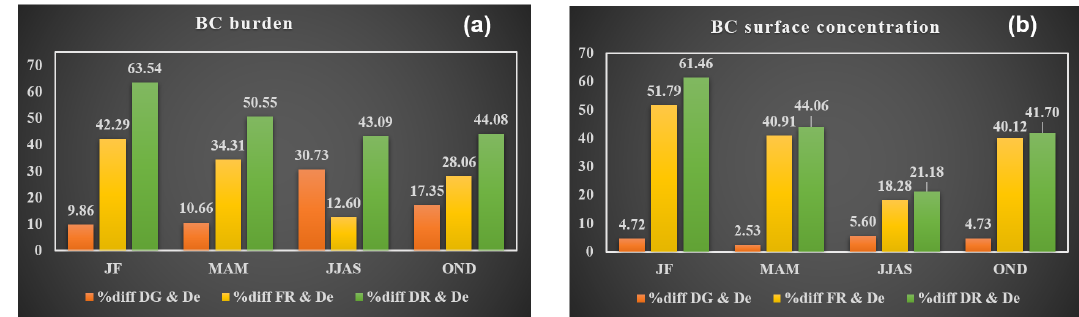
Figure 9. Seasonal variations in the percentage changes in the (a) BC burden (mgm − 2 ) and (b) BC surface concentration (µgm − 3 ) for each sensitivity experiment with respect to the default set-up, where “De” represents Default, “DG” represents Dyn_global, “FR” represents Fix_Regio, and “DR” represents